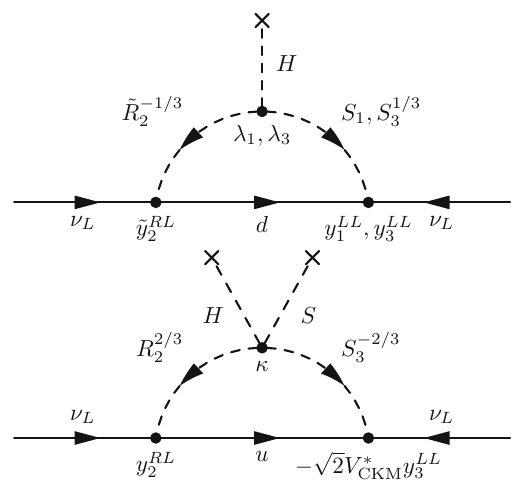
Fig. 1 The one-loop neutrino mass diagrams for the S 1 , 3 – ˜ R 2 ( S 3 – R 2 ) scenario in the upper ( lower ) panel . See text for full